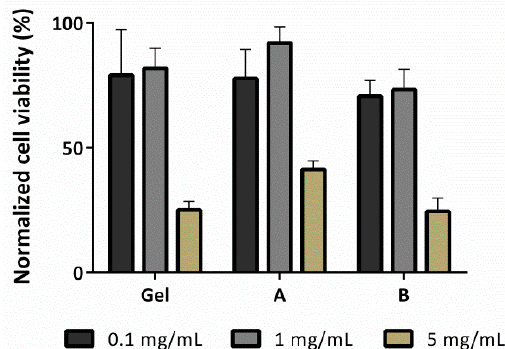
Figure 12. Cell viability of the macrophage cells after treatment with the different materials at different concentrations.